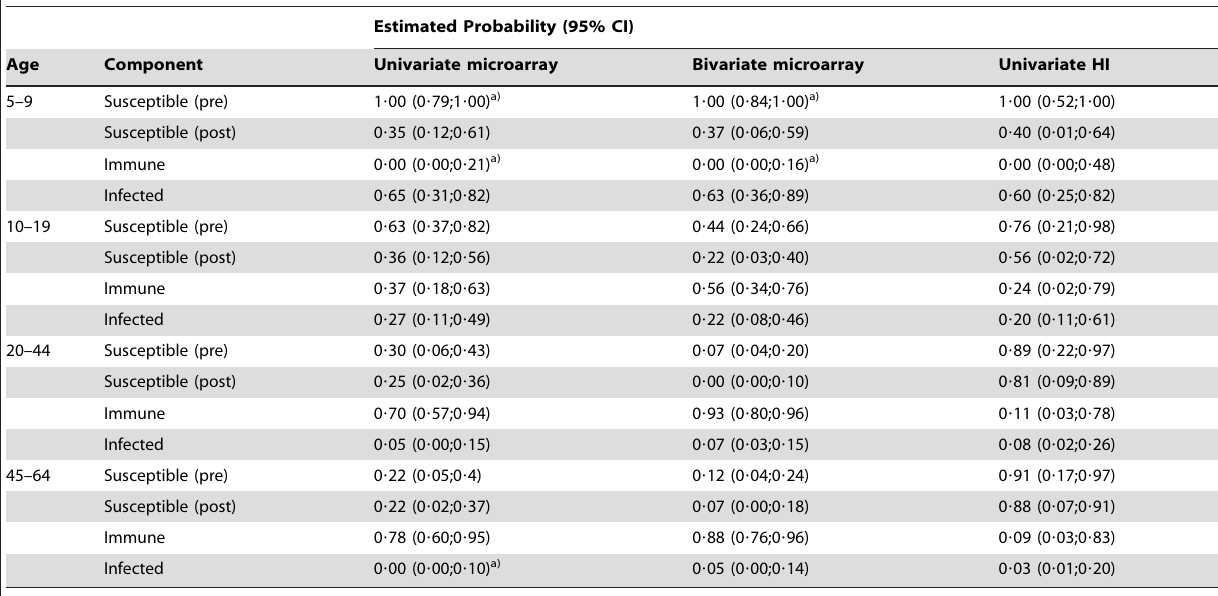
Three scenarios are considered, viz. a univariate model that uses A/2009 (H1N1) microarray data (‘Univariate microarray’), a bivariate model that uses A/2009 (H1N1) and A/1918 (H1N1) microarray data (‘Bivariate microarray’), and a univariate model of hemagglutination inhibition data using A/2009 (H1N1) (‘Univariate HI’). See Table S2 and Table S3 for estimates of the parameters of the distributions. a) one-sided confidence interval. g ( i ) the age label of sample i , and by w ( i ) the population weight of sample i . With these notational conventions the log-likelihood of